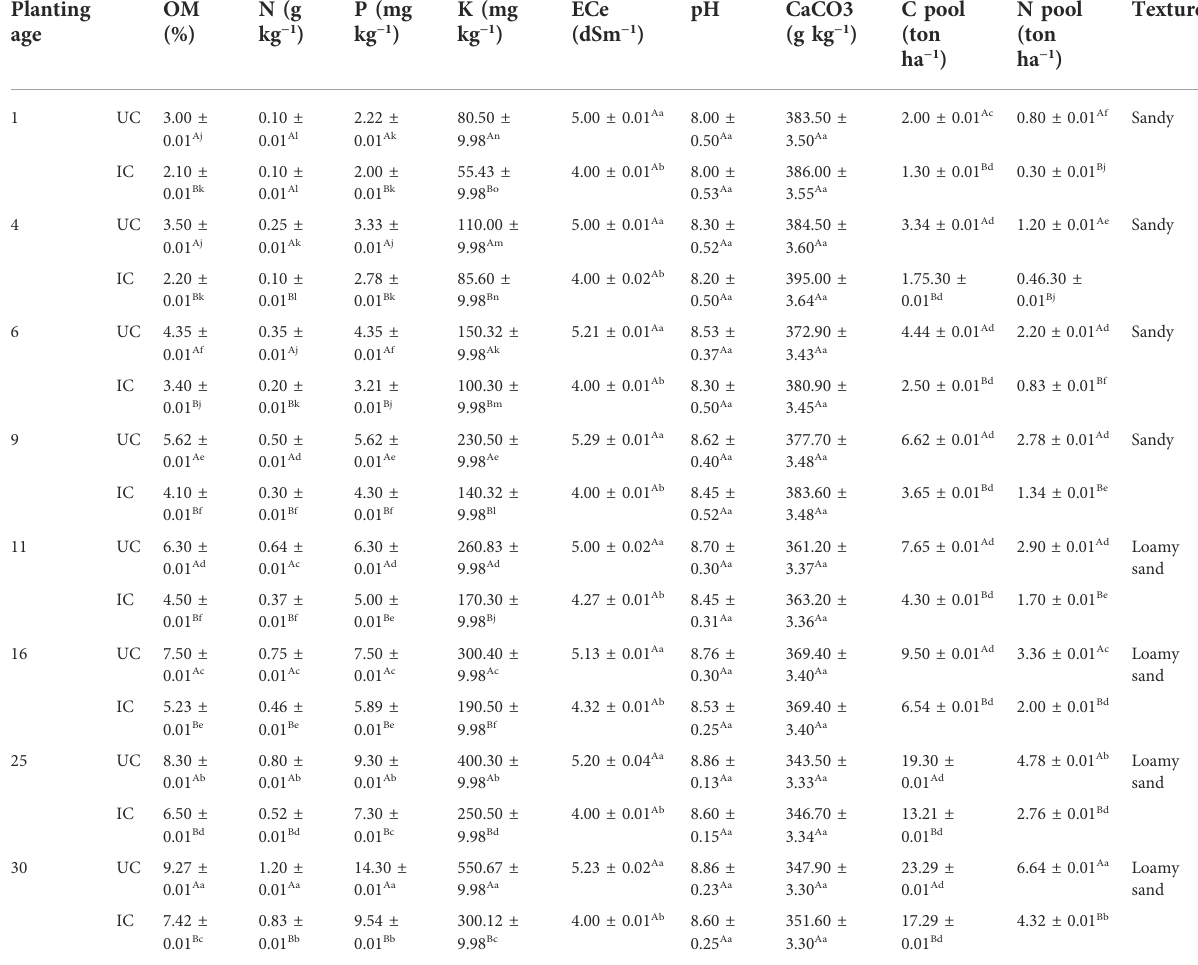
TABLE 2 Characteristics of soil under canopy (UC) and inter canopy (IC) in the eight Calligonum planting sites. Planting